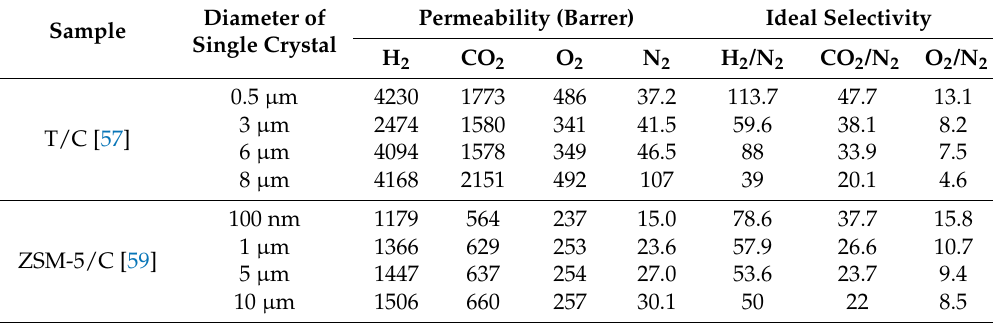
Table 5. The effect of crystal diameter on the gas separation performance of the zeolite/C hybrid membranes (zeolite content in precursor of 10 wt% unless otherwise indicated). Diameter of Permeability (Barrer) Ideal Selectivity Sample Single Crystal